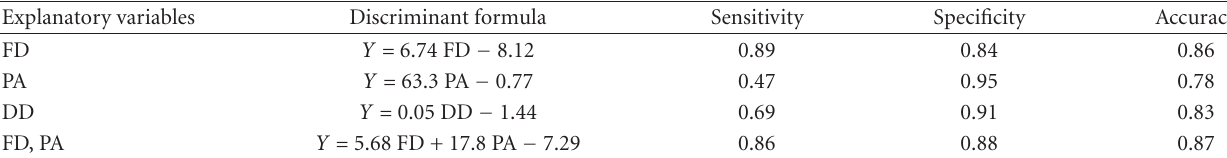
Table 2: The results of discriminant